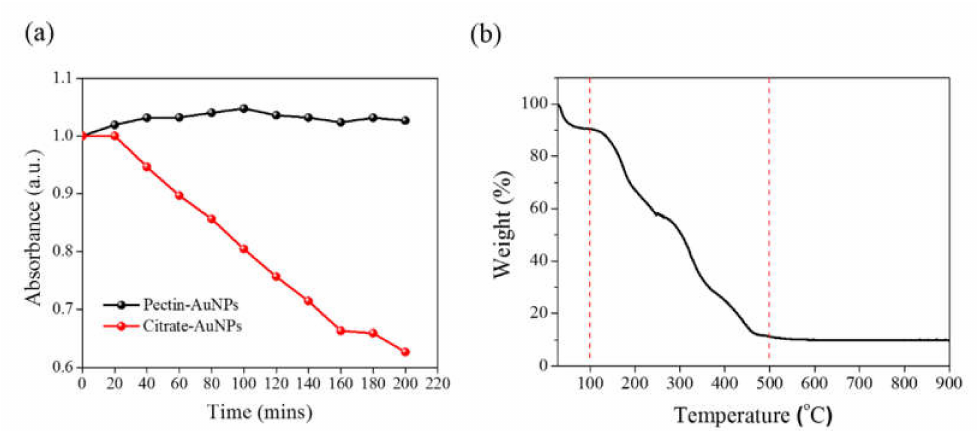
Figure 2. ( a ) Time-dependent absorbance of AuNPs in the water solution under 80 ◦ C and ( b ) TGA analysis of pectin-capped AuNPs.